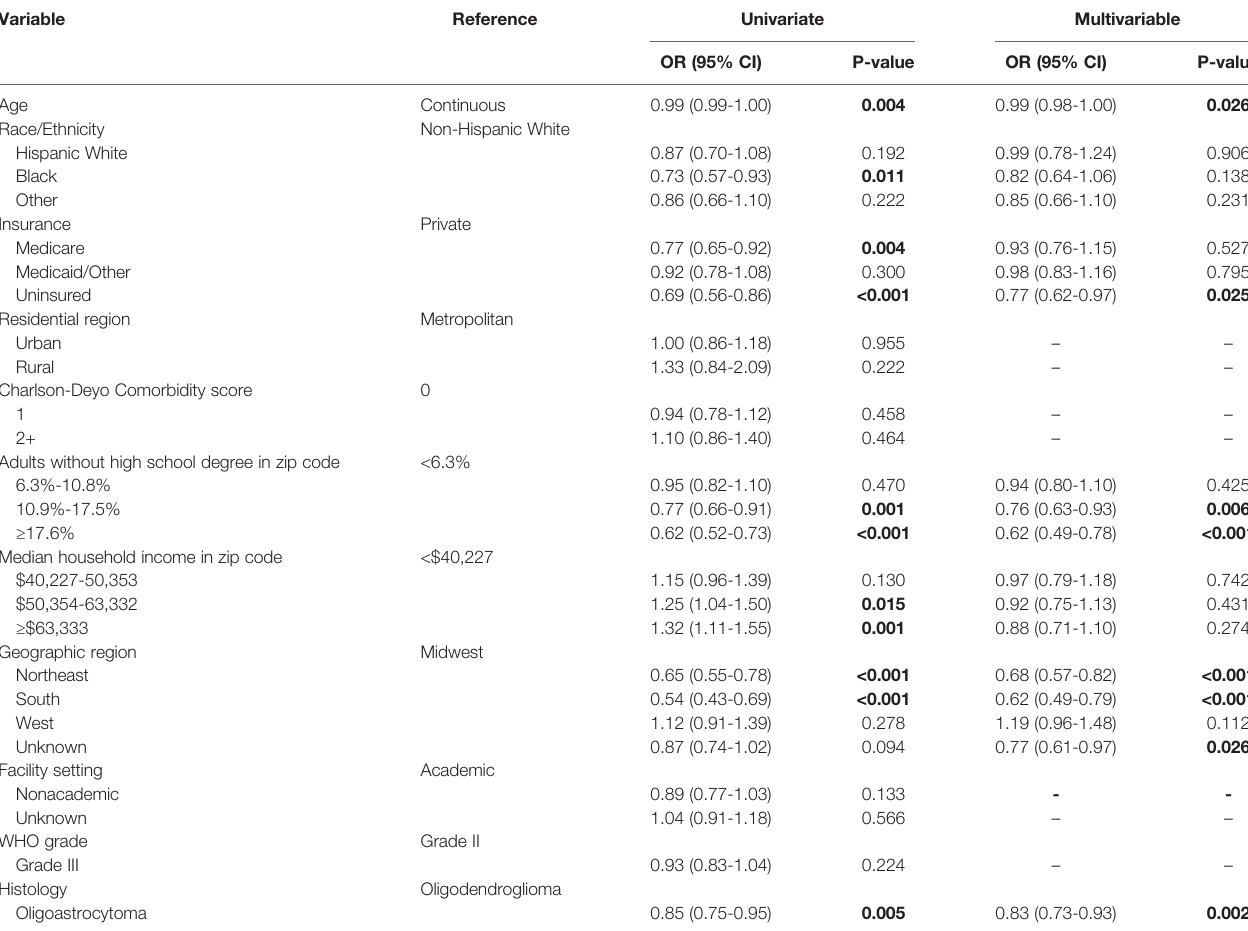
TABLE 2 | Univariate and multivariable logistic regression evaluating factors associated with reporting of a 1p/19q codeletion test for patients diagnosed from